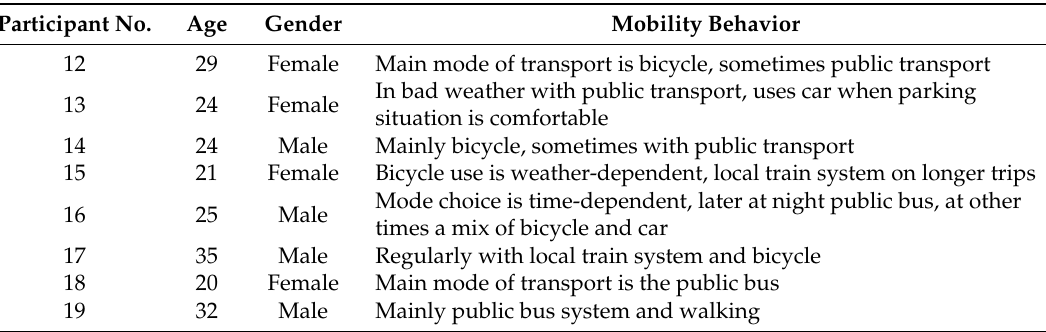
Table 2. Sample of focus group #2